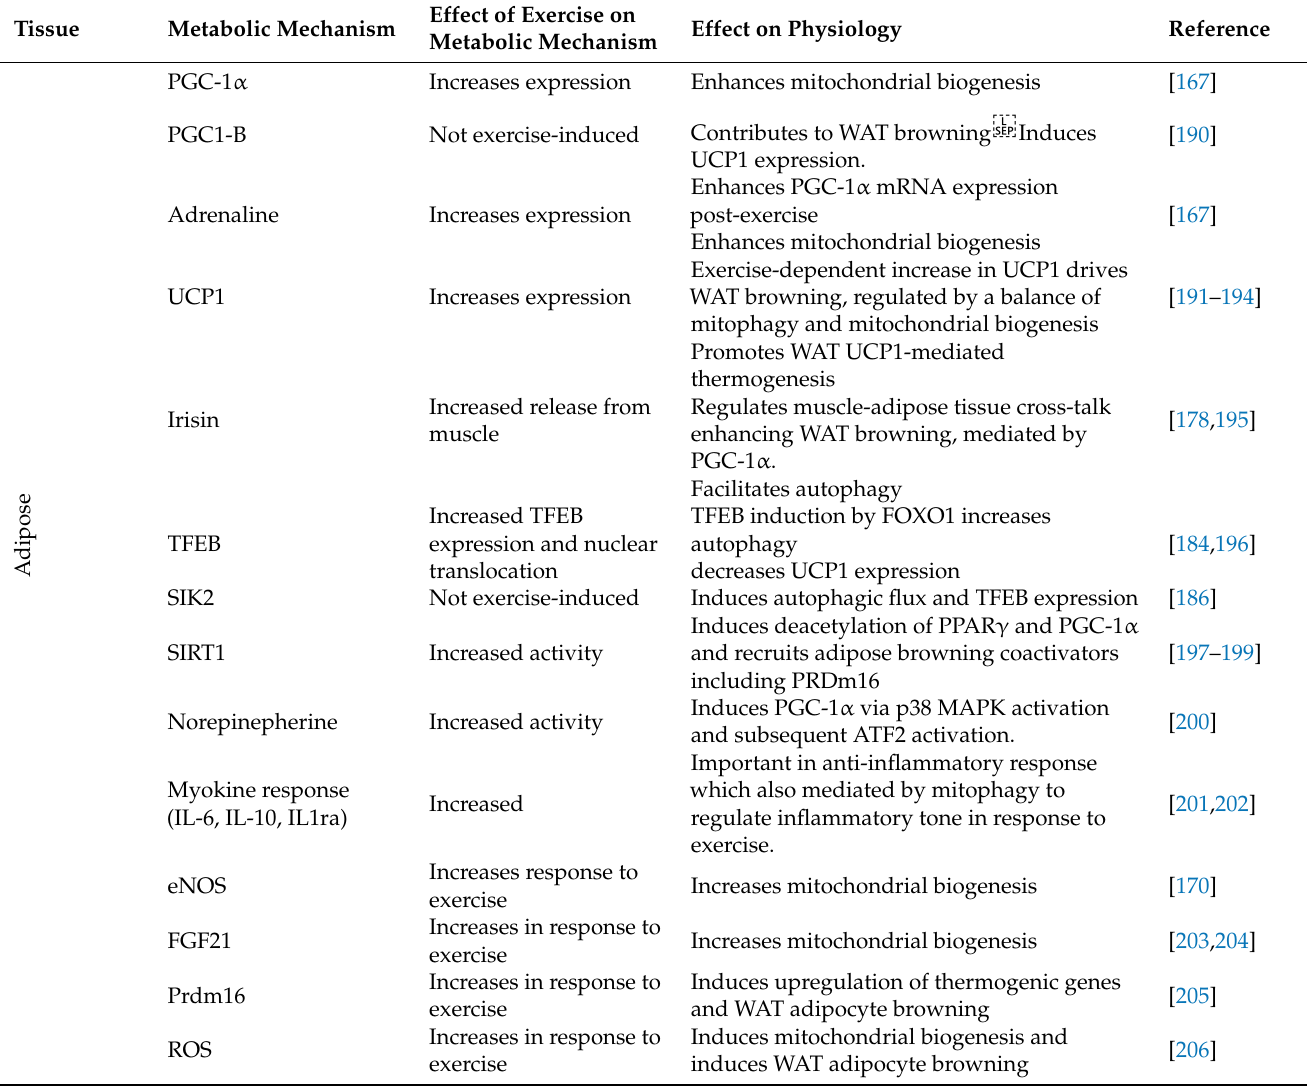
Table 1. Key exercise-dependent molecular mechanisms regulating adipose tissue.